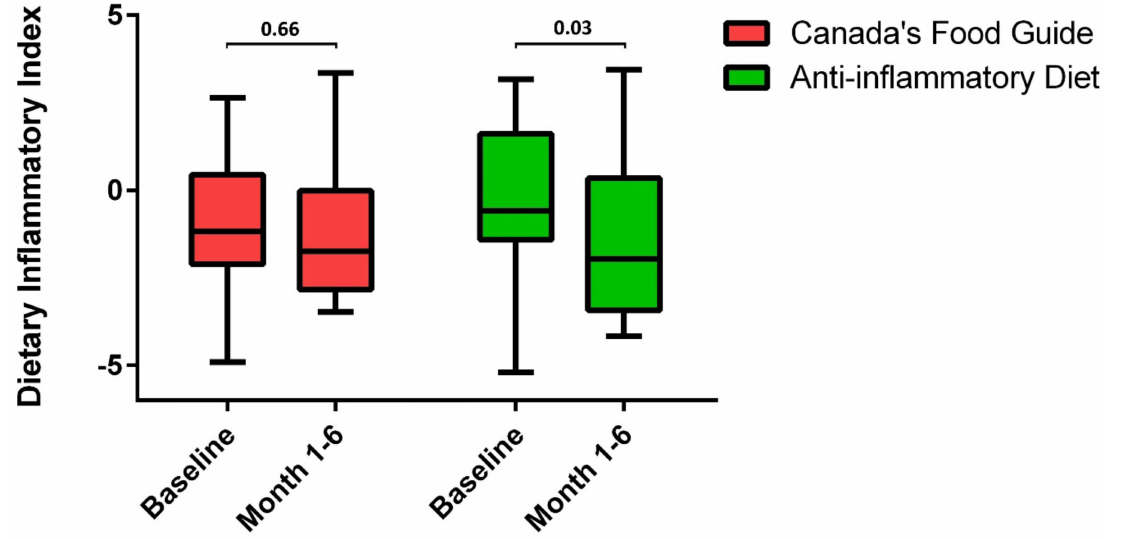
Figure 3. Comparison of dietary inflammatory index (DII) scores (median and interquartile range) from baseline to the end of the trial between the two intervention groups. There was a significant decrease in DII scores in patients randomized to the Anti-inflammatory